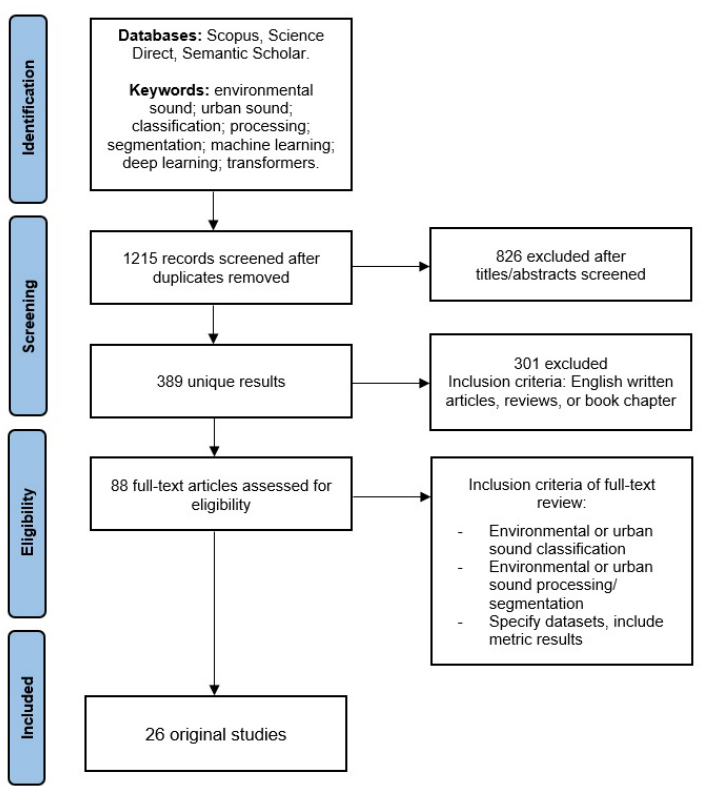
Figure 2. PRISMA diagram of the performed literature search process (adapted from Page et al.